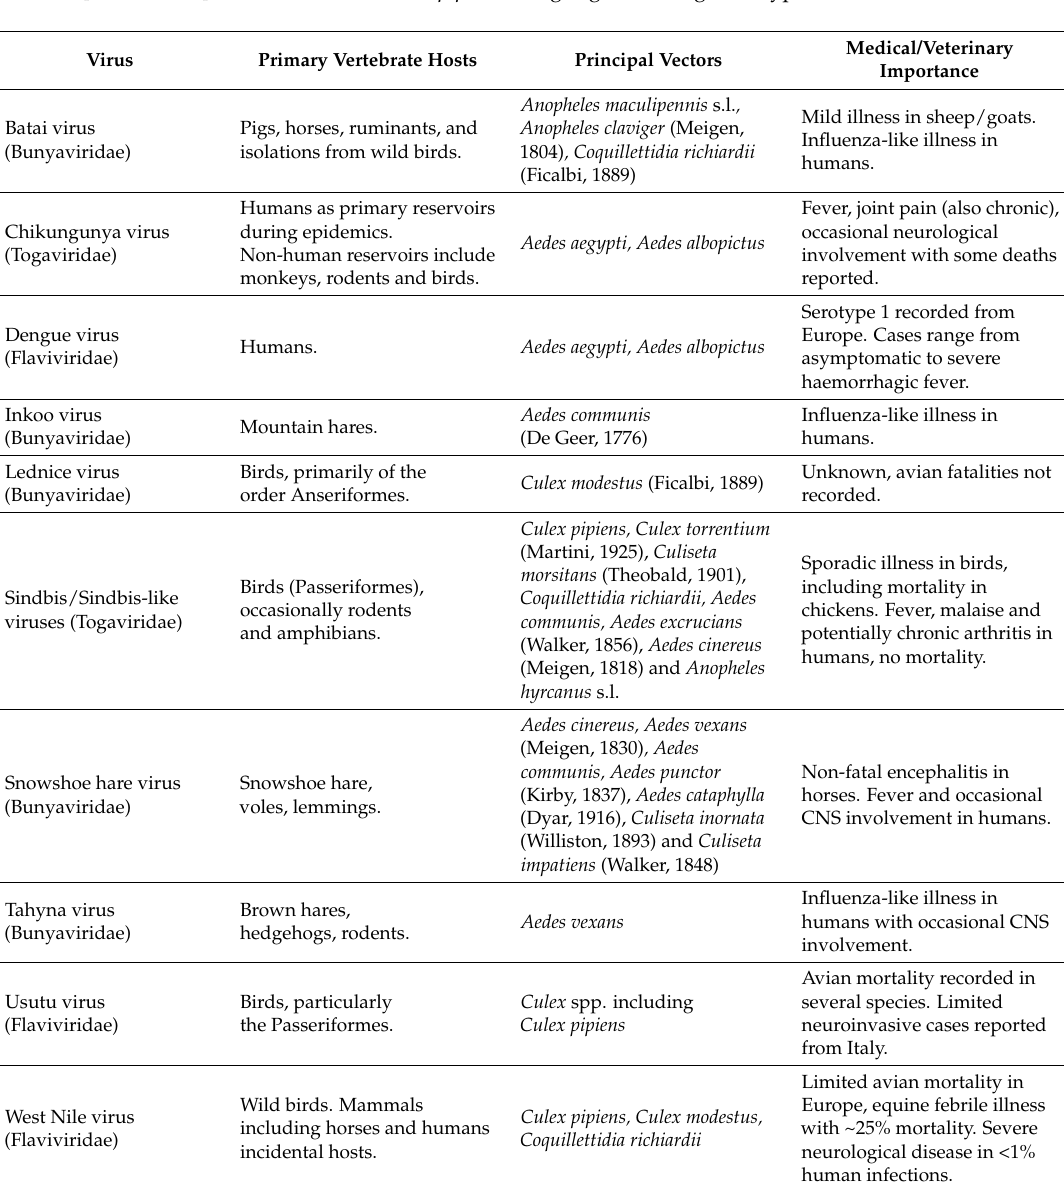
Table 1. Mosquito-borne viruses of medical and veterinary importance circulating in Europe, after [23,24,39–43]. Involvement of Culex pipiens is highlighted using bold